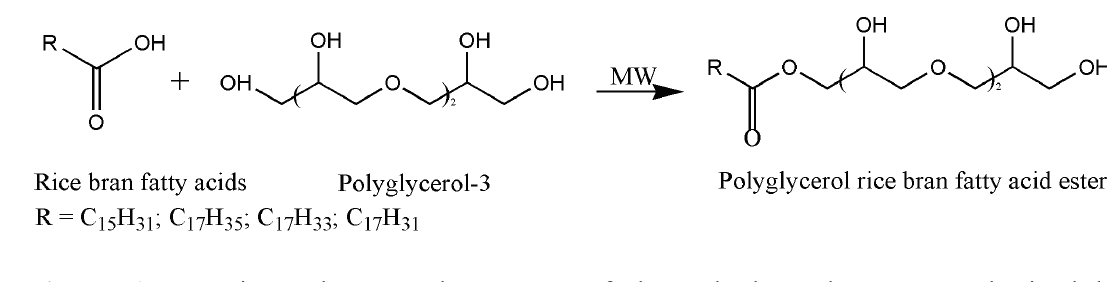
Figure 1. Reaction scheme and structure of the polyglycerol esters synthesized by microwave-assisted irradiation process.